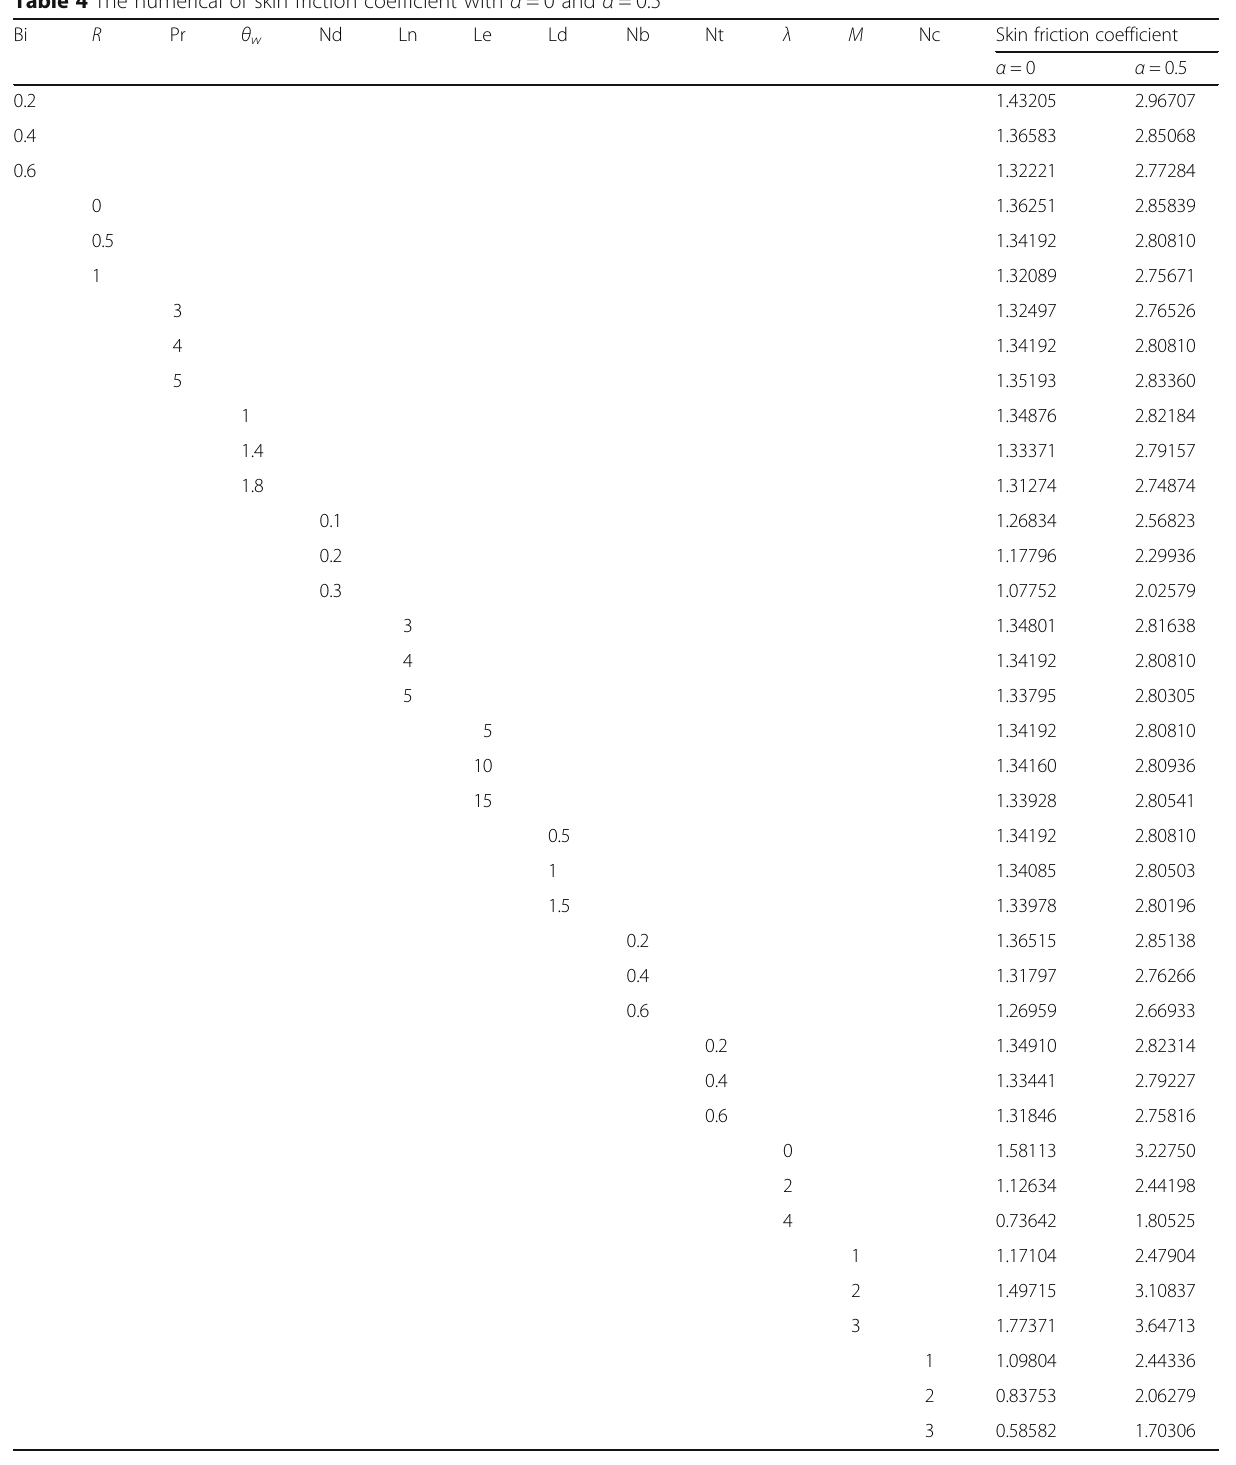
Table 4 The numerical of skin friction coefficient with α = 0 and α =